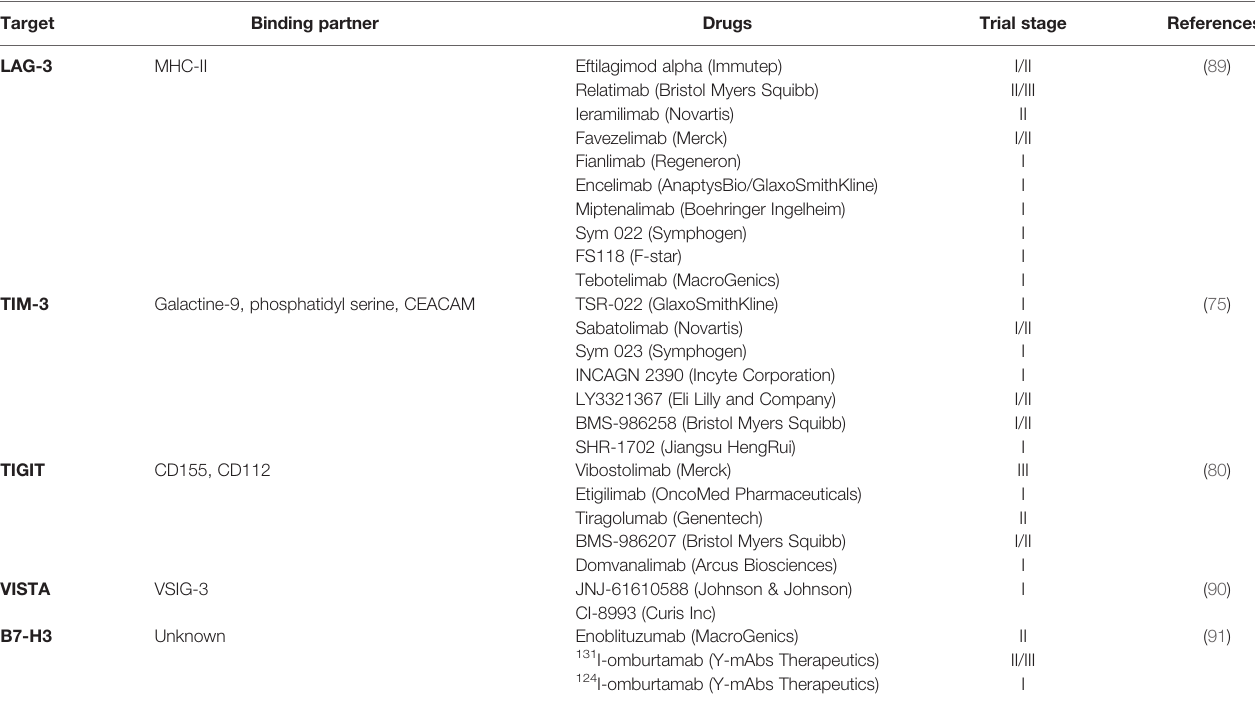
TABLE 2 | Next generation immune checkpoint